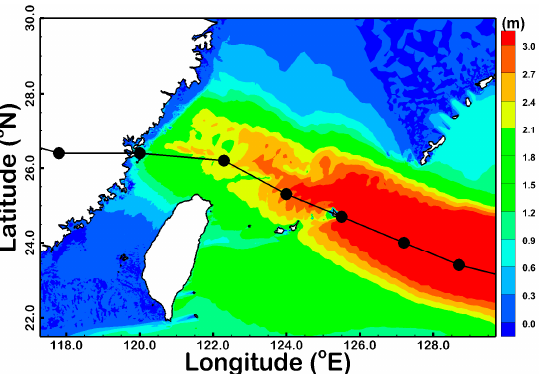
Figure 4. Spatial distribution of the difference in maximum SWH using the winds from H_4R max and the original ERA5 during the passage of Super Typhoon Maria in 2018.